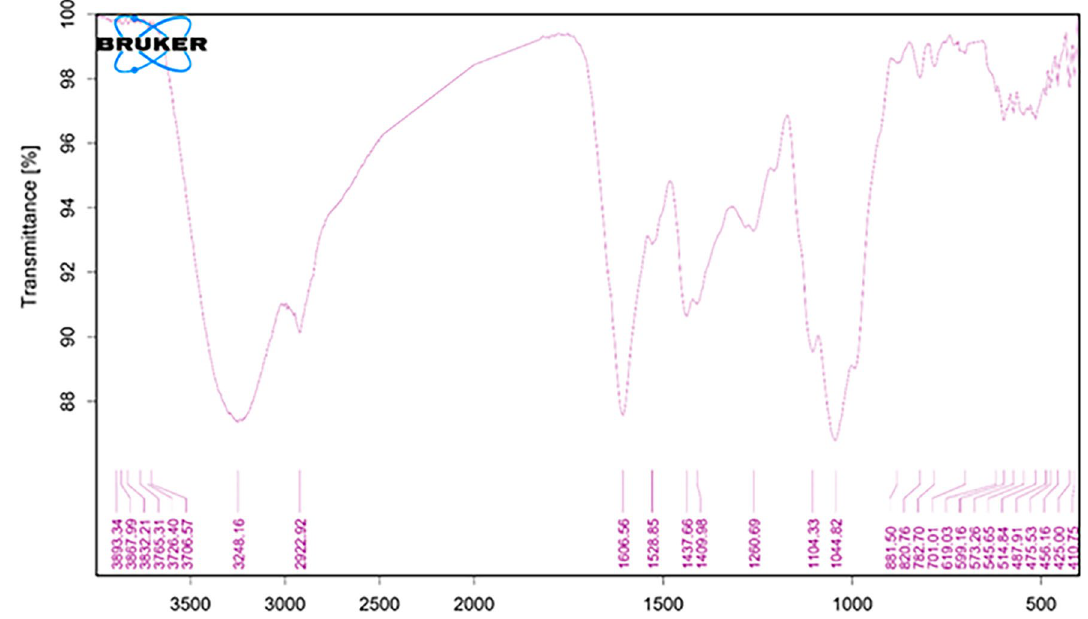
Fig. 2 FT-IR spectrum of crude methanolic extract of Enhalus acoroides (L.f.) Royle rhizome